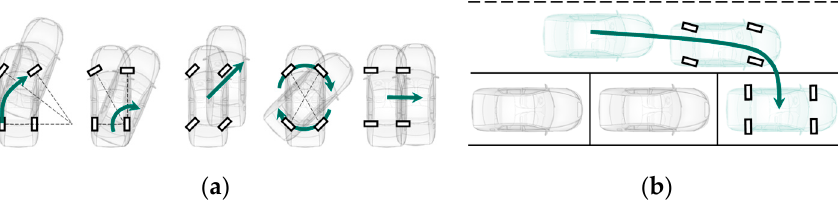
Figure 1. ( a ) Possible driving modes using novel suspensions; ( b ) possible continuously driven parking maneuver using novel suspensions.